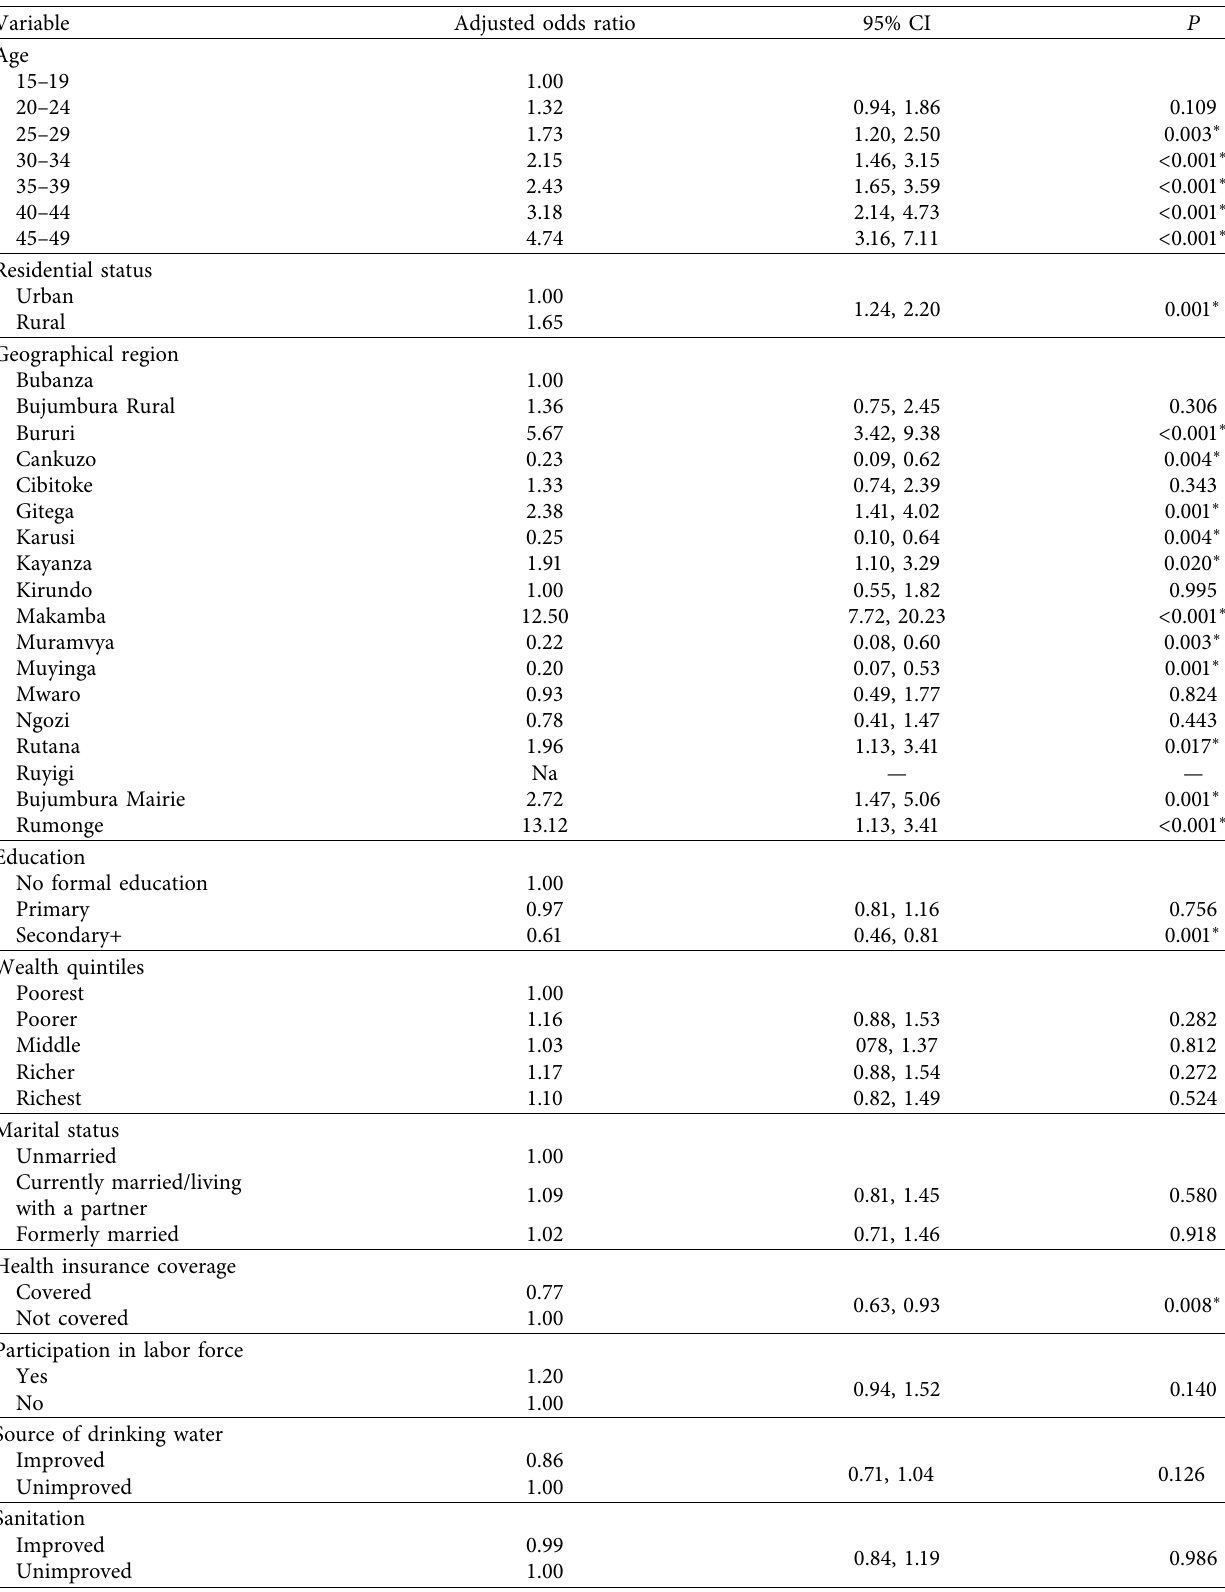
Table 3: Multivariable logistic regression of the factors associated with renal